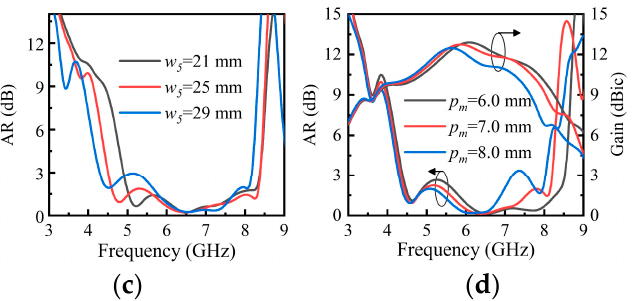
Figure 6. Parametric studies on ( a ) the radius of phase delay line r c , ( b ) the width of phase delay line w c , ( c ) the width of ends w 5 , ( d ) the side length of the AMC unit p m .